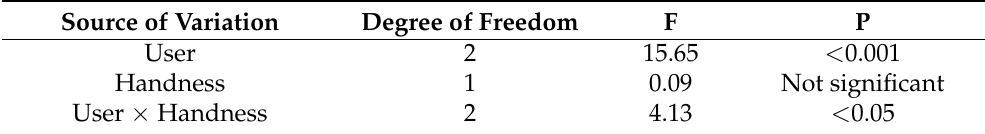
Table 4. Results from two-way ANOVA on time data as a function of user and handness. Source of Variation Degree of Freedom F P User 15.65 < 0.001 Handness User × Handness 4.13 < 0.05